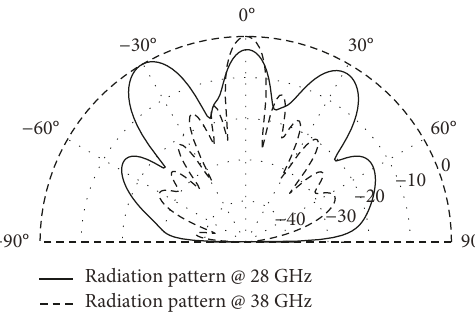
Figure 9: Synthesized dual-band multibeam re fl ectarray: simulated radiation patterns at the designed frequencies.